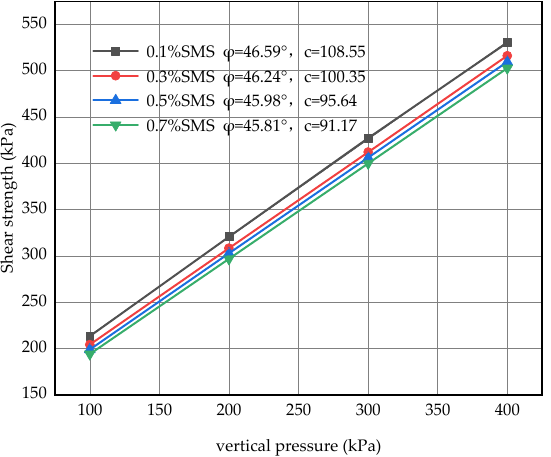
Figure 6. Changes in shear strength of 10% NHL2 with vertical pressure.